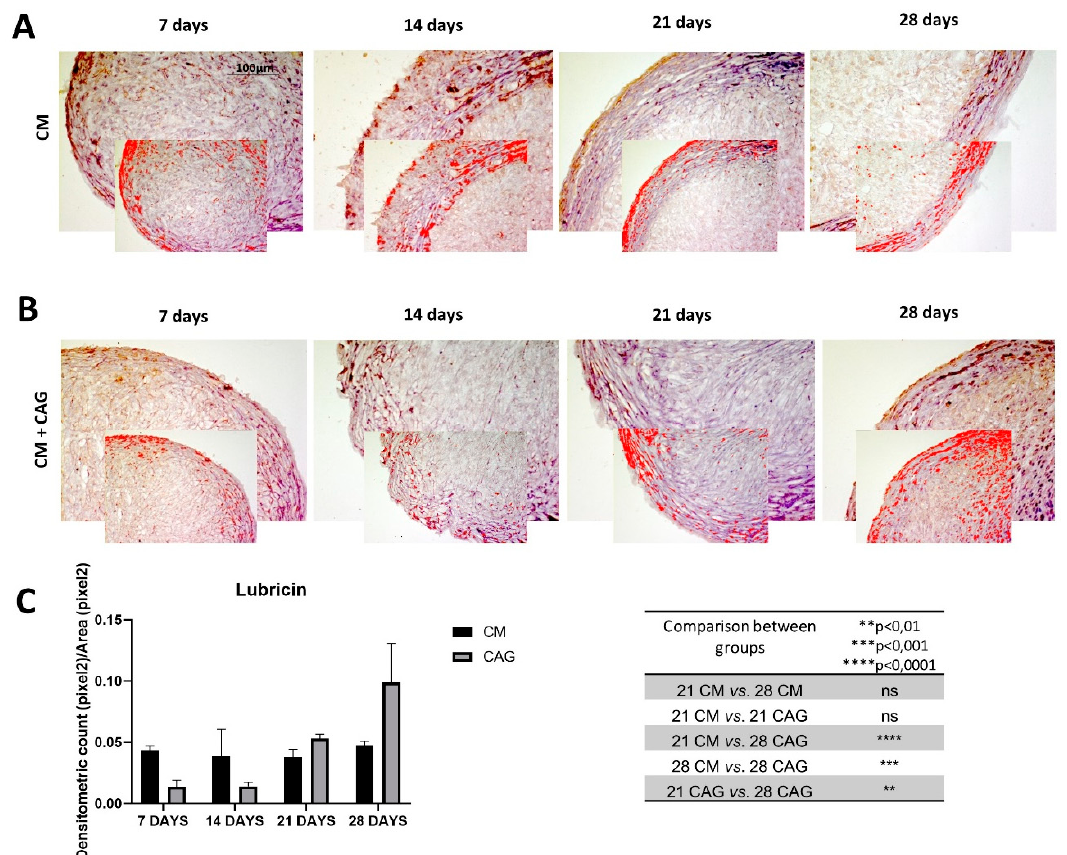
Figure 6. Lubricin immunohistochemical evaluation in 3D AMSC-derived chondropellets at 7, 14, 21, and 28 days of culture through computerized densitometric measurements and image analysis. ( A ) control group (chondrogenic medium: CM); ( B ) CAG-supplemented group (CM + CAG). The smaller attached images represent the image analyses by the software: red color corresponds to brown staining (immune complexes labelled with chromogen). ( C ) Graph representing the level of staining expressed as densitometric count (pixel 2 ) normalized to the area of each section expressed in pixel 2 . Results were presented as the mean ± SD. ANOVA was used to evaluate the significance of the results. ** p < 0.01; *** p < 0.001; **** p < 0.0001; ns, not significant. See the Materials and Methods section for details. Objective lens, 10×; scale bar: 100 μ m.